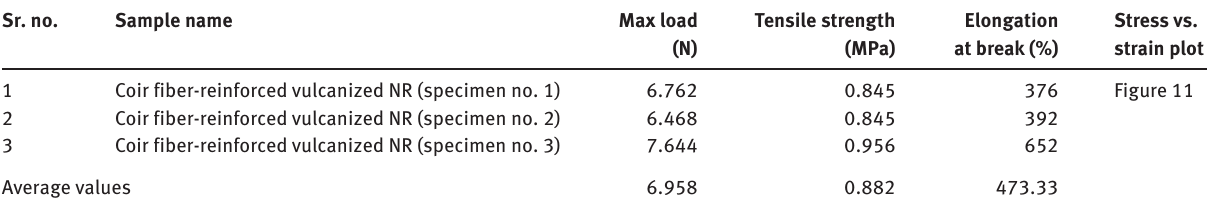
Table 9: Mechanical properties of coir fiber-reinforced vulcanized NR composite after heat resistance at 80 ° C for 4 h. Sr. no.